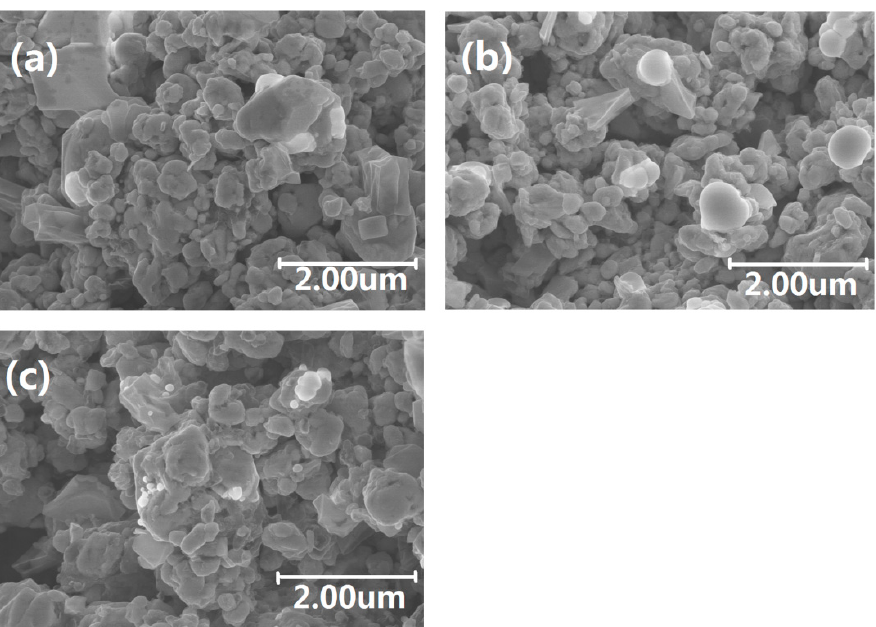
Figure 2. SEM images of of (Bi 0.48 Sb 1.52 )Te 3 thick films annealed at ( a ) 500 °C, ( b ) 550 °C and ( c ) 600 °C, respectively.